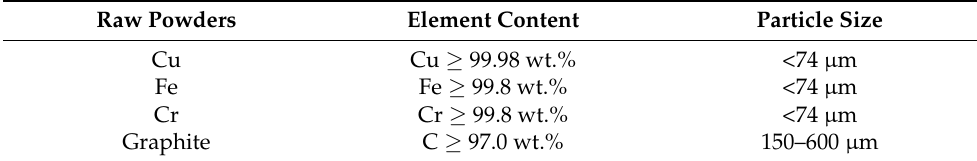
Table 2. Characteristics of the raw powders.